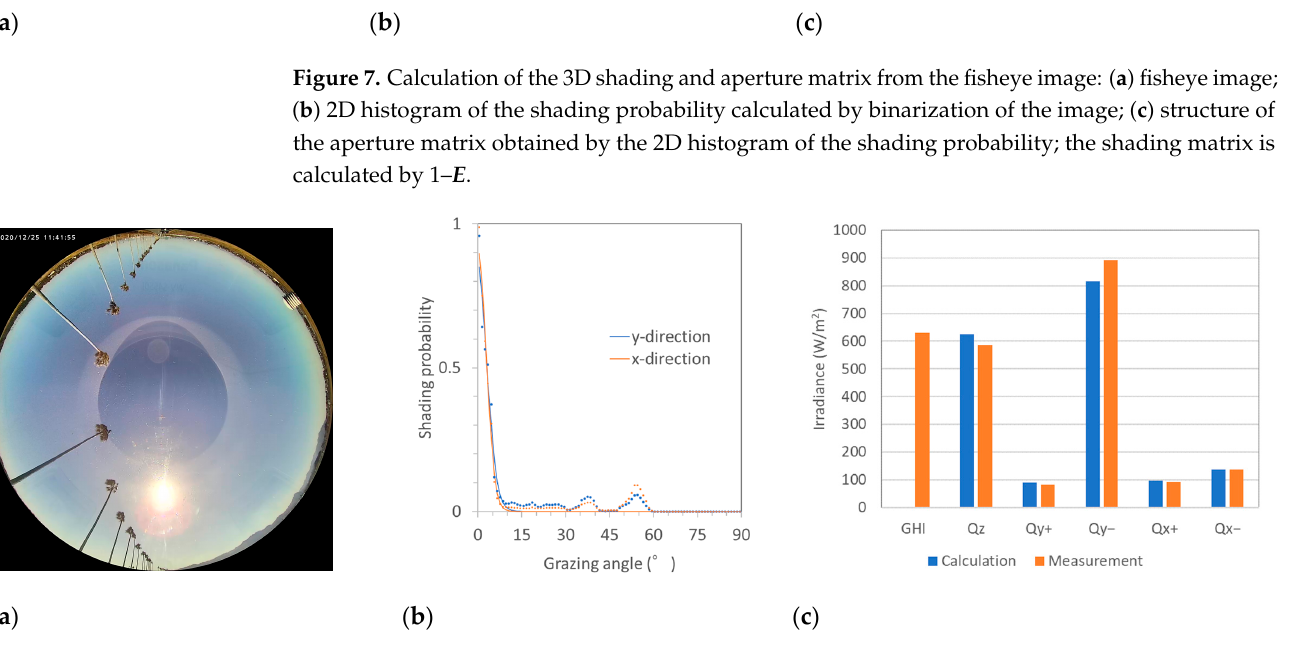
Figure 8. Shading distribution and irradiance onto VIPVs (5-axis) of the open zone: ( a ) fisheye image; ( b ) shading probability as the function of the grazing angle; ( c ) comparison of the measured (red bars) and calculated (blue bars) irradiance onto 5-axis planes.